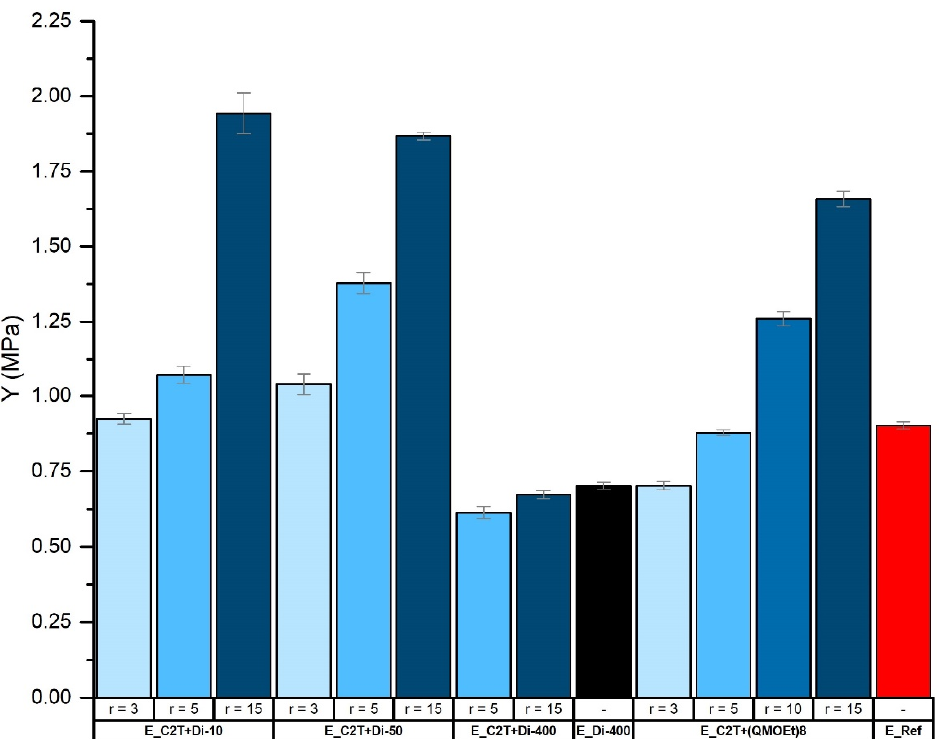
Figure 8. Young´s moduli (MPa) of commercial coating E_Ref and elastomers prepared via the reaction between C2T and Di-10, Di-50, Di-200, and (QMOEt)8, respectively. Film thickness was ~100 µm.